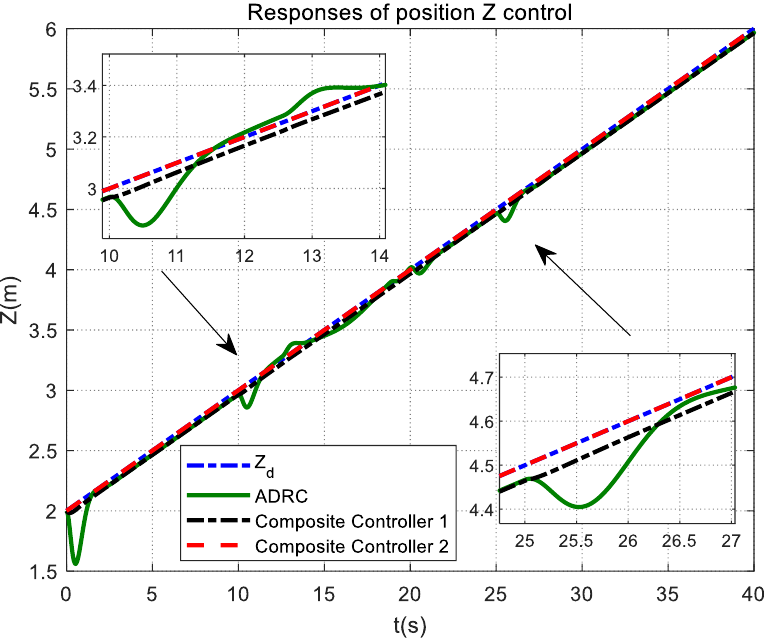
Figure 10. Responses of position Z control for QUAV under actuator constant and disturbance fault condition.